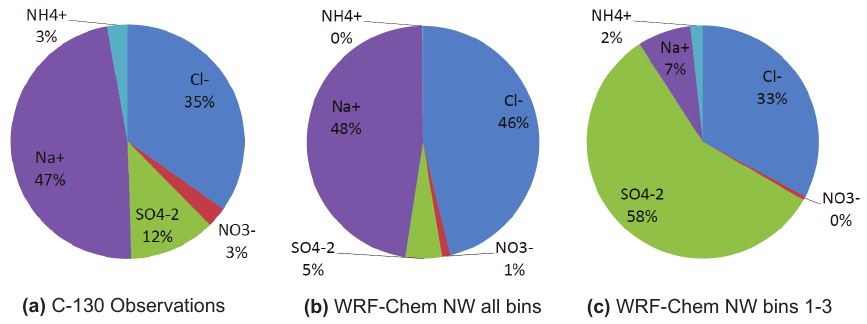
Fig. 2. Pie charts for modeled ionic species for C-130 observations representing cloud composition (a) and the no wet deposition model (NW) using collection of wet aerosol along the flight track for all bins (b) and for bin 1, 2 and 3 (40nm to 300nm aerosol diameter) only (c) . Units are in